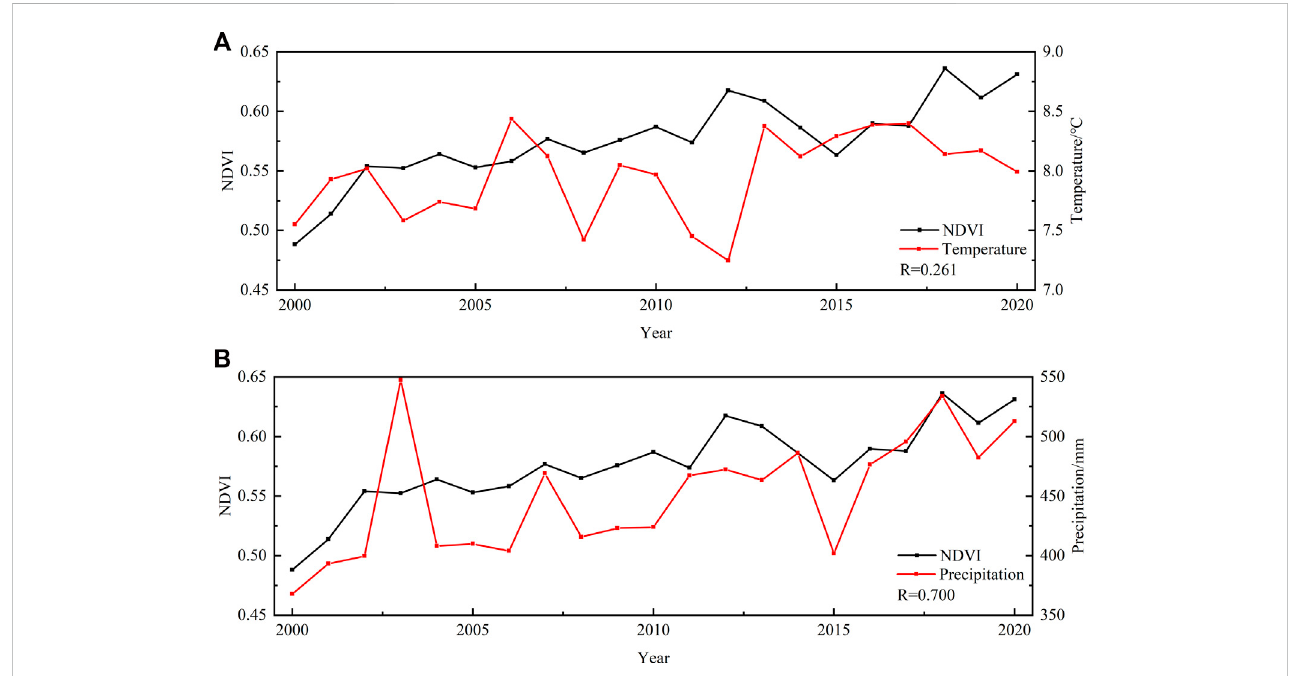
FIGURE 9 Temporal trends of annual mean temperature (A) , annual precipitation (B) , and